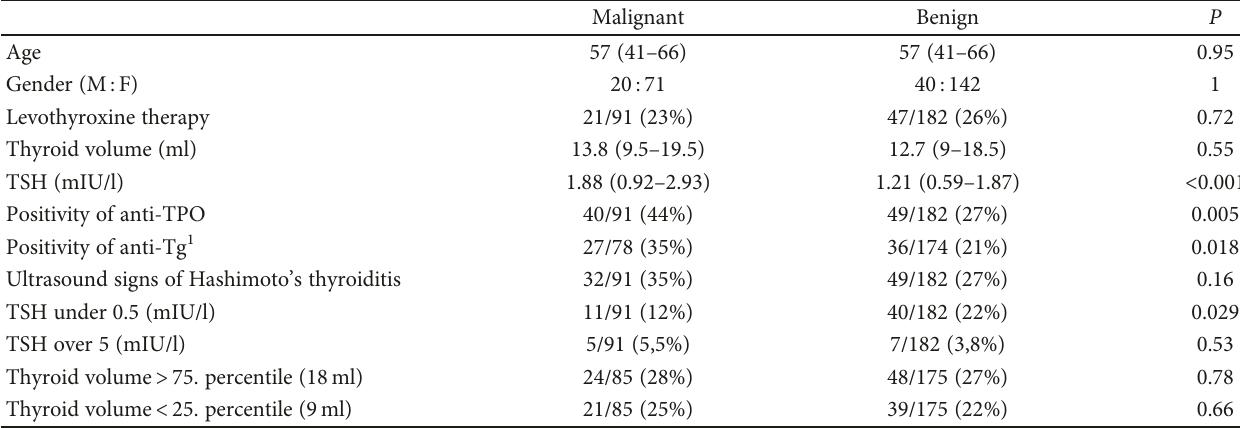
Table 2: Characteristics of patients with thyroid cancer and benign nodules. Thyroid hormone therapy, positivity of anti-TPO and anti-Tg, ultrasound signs of Hashimoto ’ s thyroiditis, TSH < 0.5mIU/l, TSH > 5mIU/l, TV > 75, and percentile and thyroid volume < 25. Percentiles are expressed in percent.